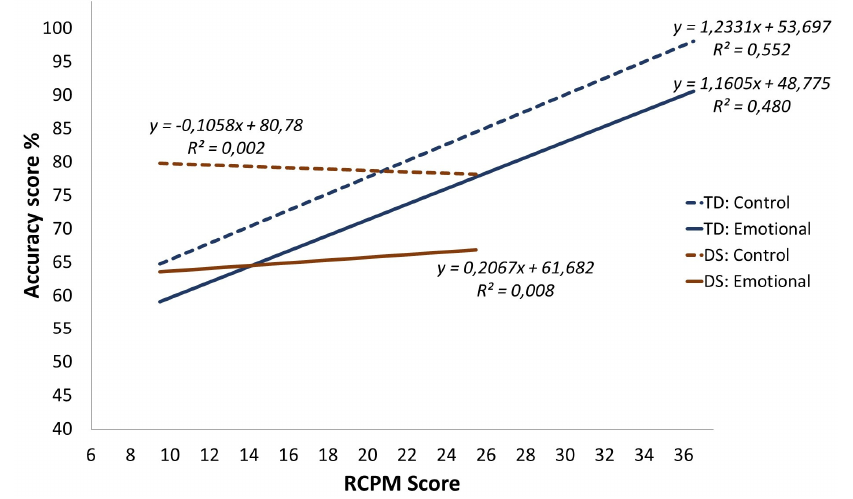
Figure 2. Cross-sectional developmental trajectories for the experimental tasks over Raven’s Colored Progressive Matrices (RCPM) scores.